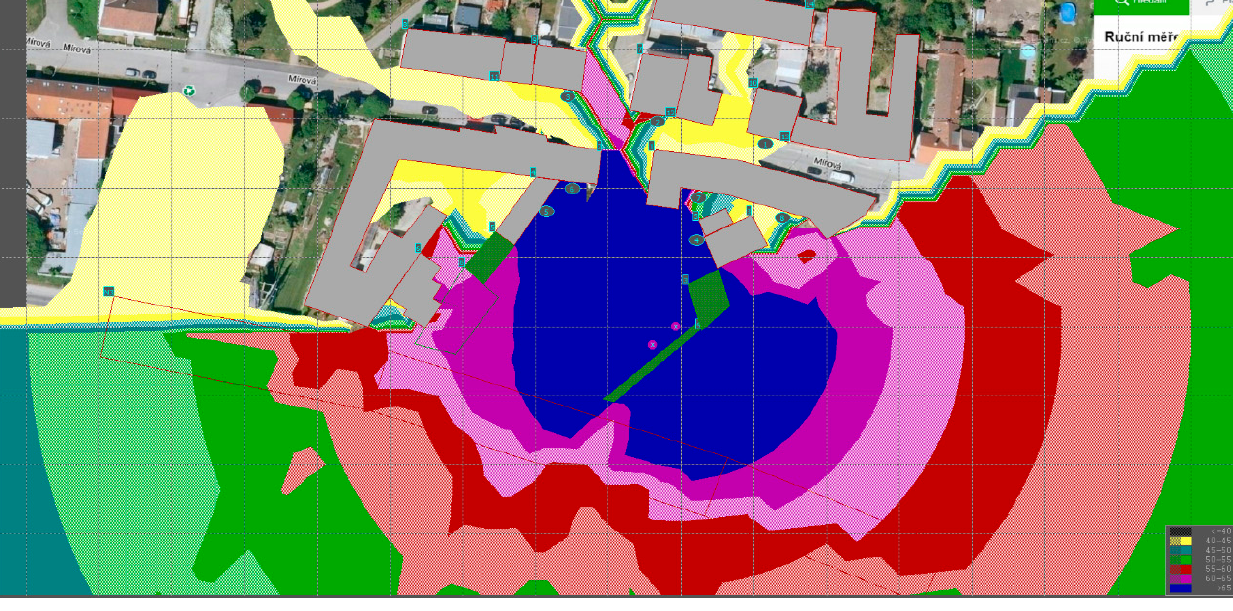
Figure 21. Colour map of isophone bands after considering acoustically significant elements (without construction site fencing or a solid gate) for final landscaping in the area in question, with the deployment of only the compaction machine.